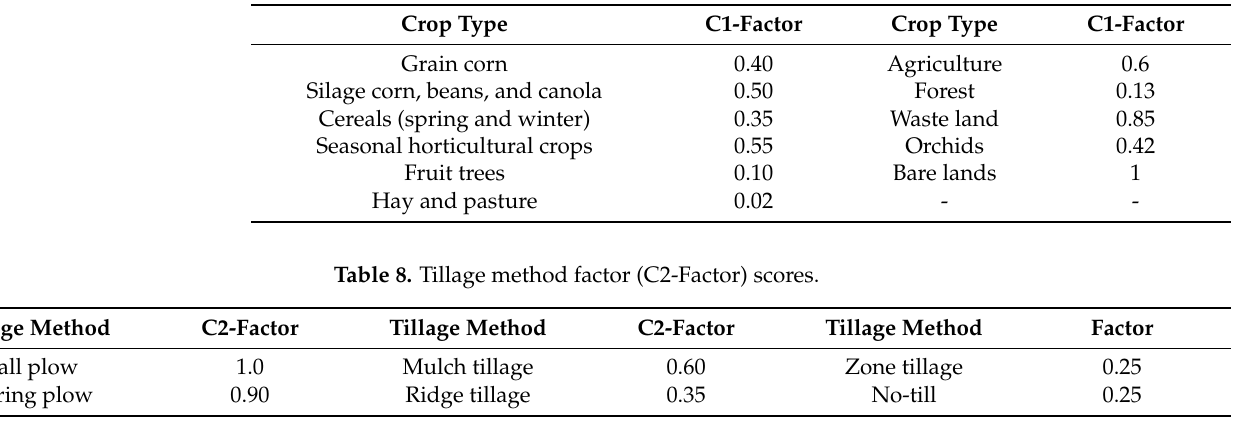
Table 7. Crop type factor (C1-Factor) scores.